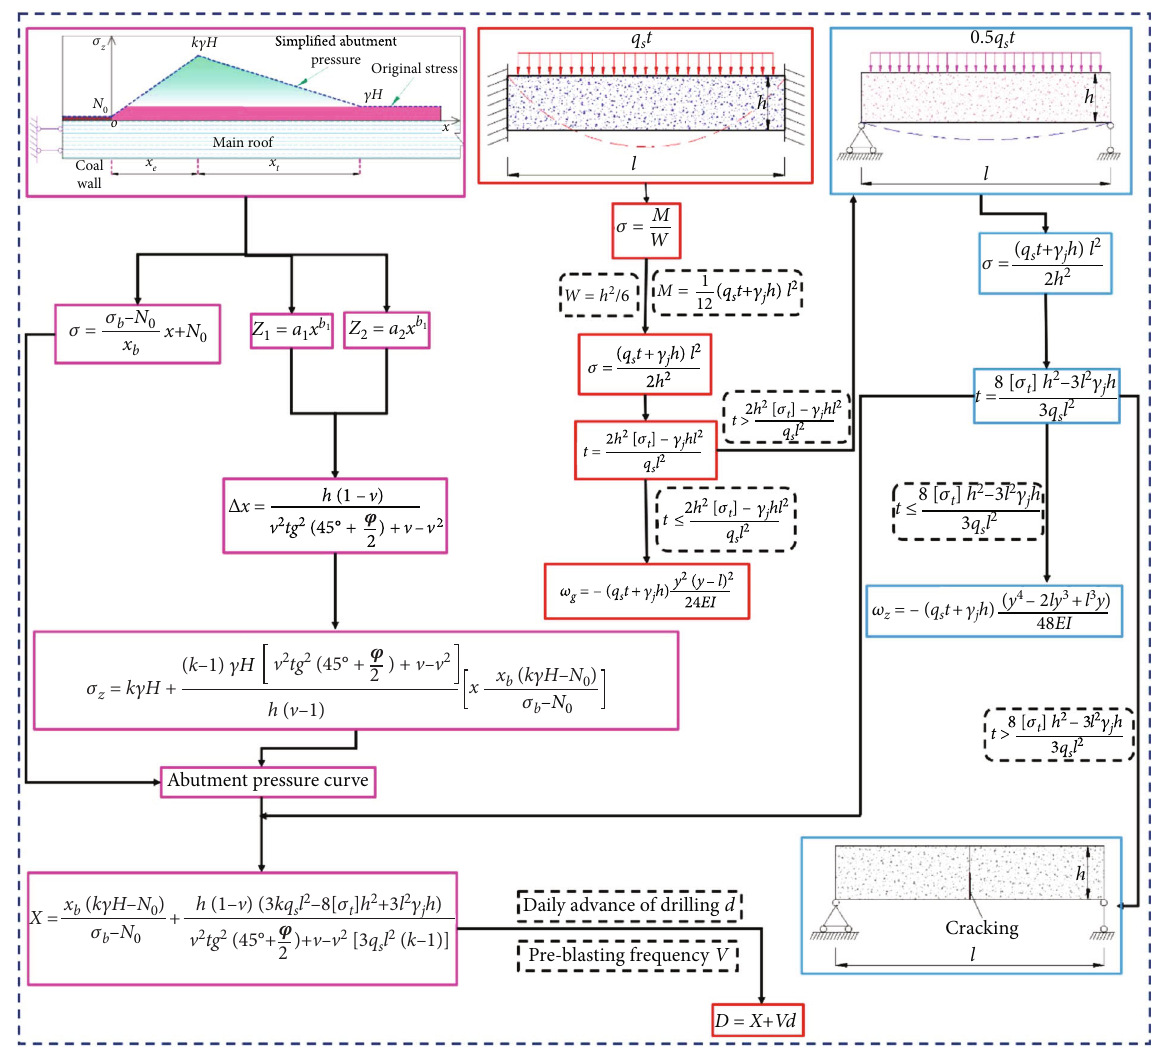
Figure 4: Flow chart of the derivation of the roof cutting